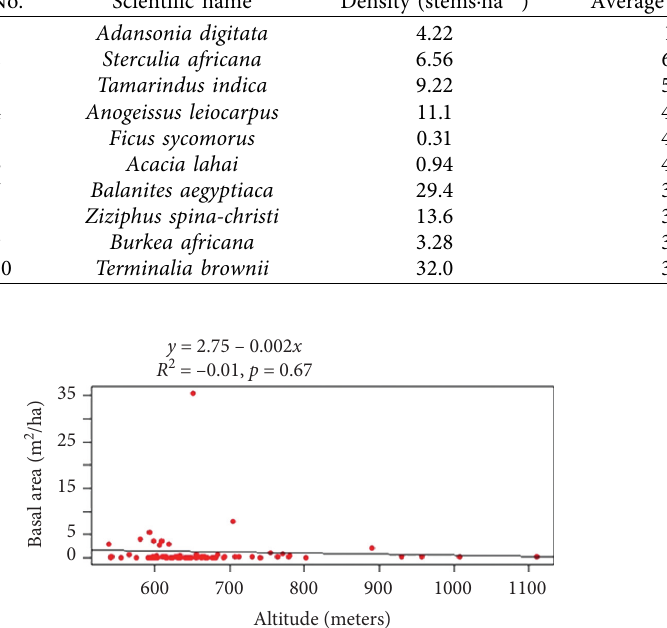
Table 5: The ten most dominant tree species to basal area (BA) in Kafta Sheraro National Park. No.